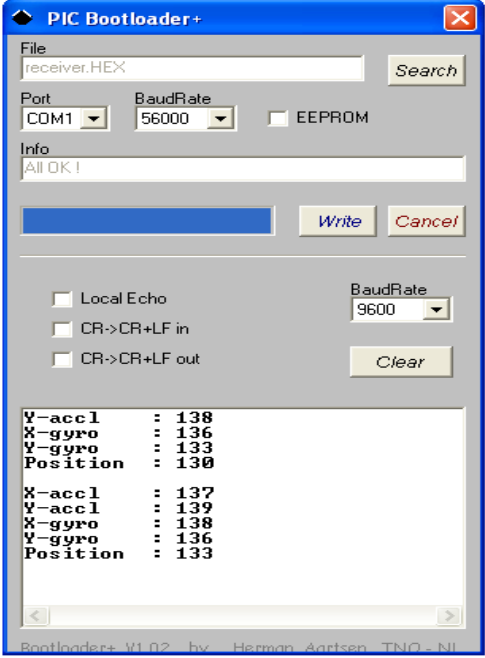
Figure 11: PIC Bootloader+